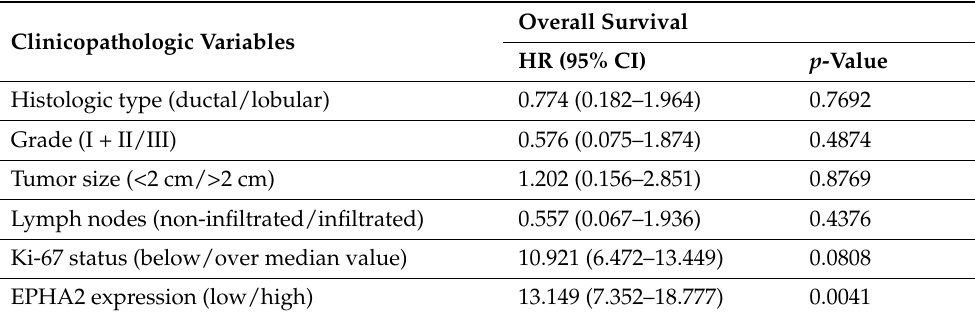
Figure 2. Kaplan–Meier survival analysis for EPHA2 high and low expression in 52 triple-negative breast cancer (TNBC) patients: overall survival ( A ) and disease-free survival ( B ). Table 4. Multivariate analysis for histologic type, grade, tumor size, lymph node status, Ki-67 status, and EPHA2 expression for